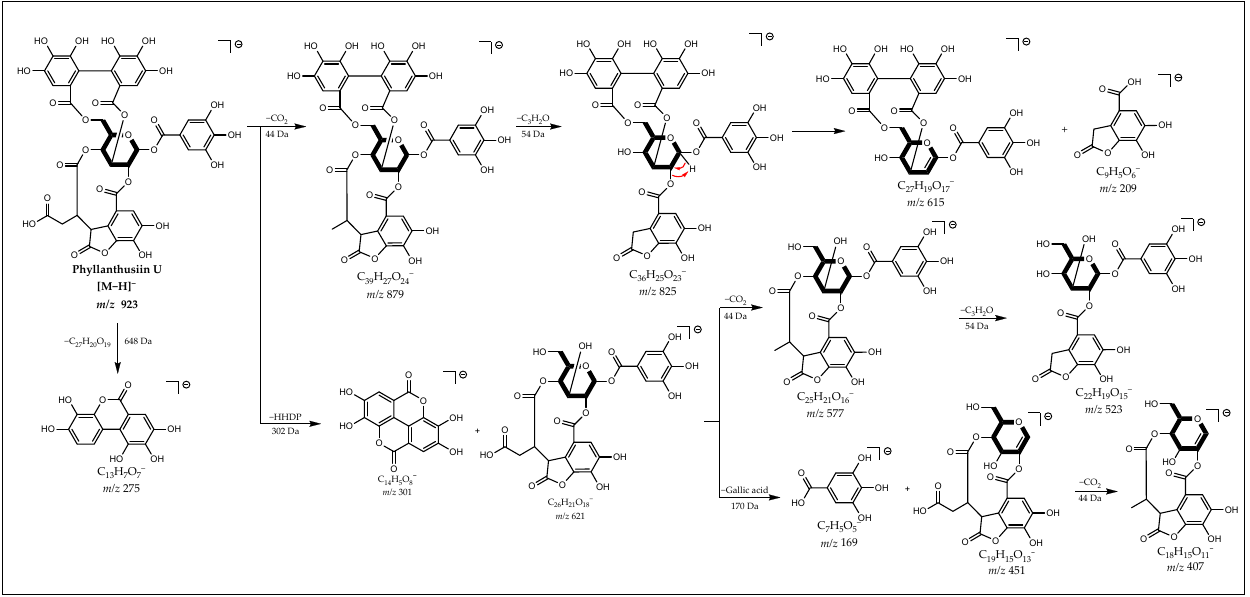
Figure 5. Proposal for fragmentation of Phyllanthusiin U Isomer.